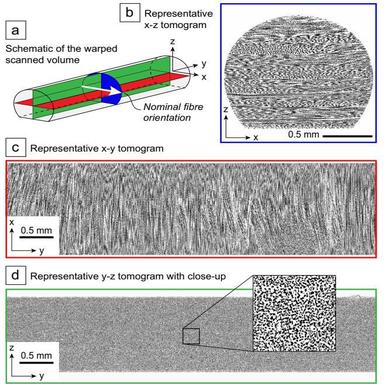
Representative tomograms obtained from processed corner-only X-μCT sample scans: (a) schematic of the warped scanned volume; (b) x-z plane; (c) x-y plane; (d) y-z plane with close-up.